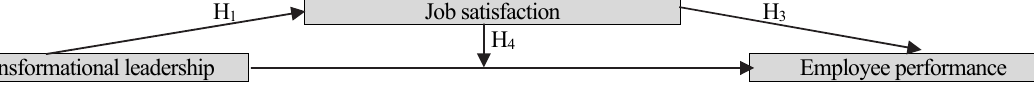
H 2 Fig. 1. Conceptual model